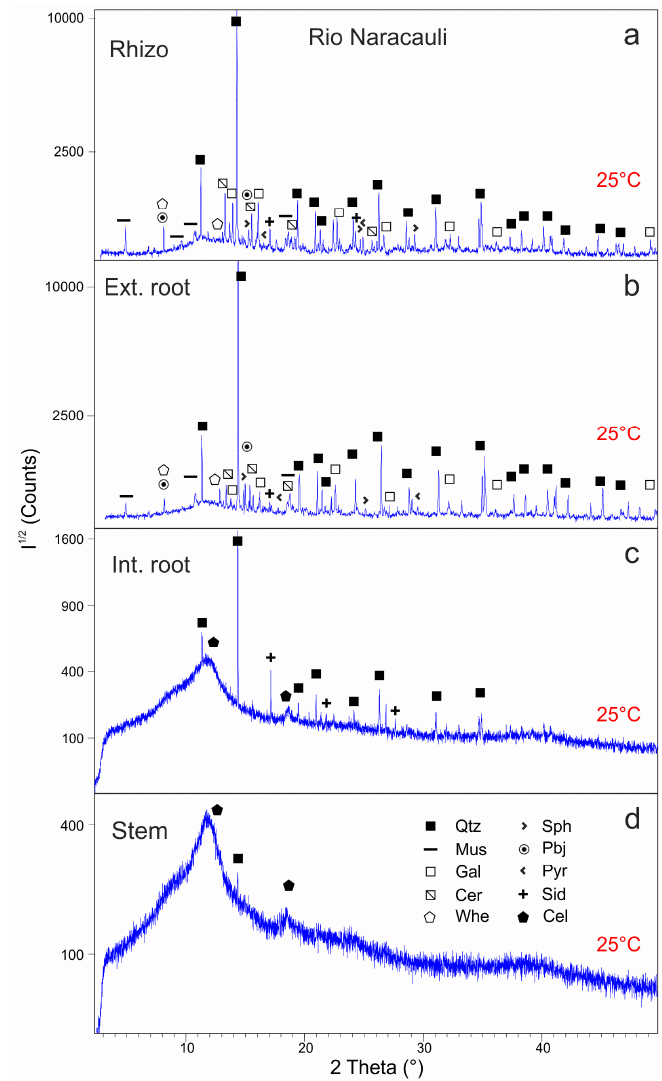
Figure 6. XRD patterns of samples from Rio Naracauli collected before heating (25 °C): rhizosphere ( a ), external root ( b ), internal root ( c ), and stem ( d ). Intensities (I 1/2 ) are reported in a square root scale. Abbreviations as in Tables 2 and 3.